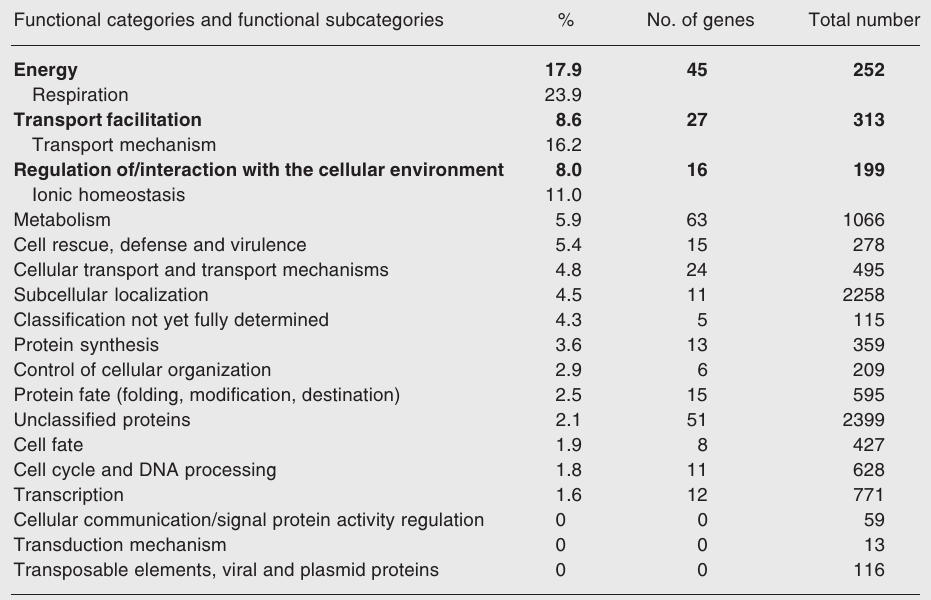
Table 1. List of functional categories and subcategories activated by nitrogen gas pressure. Functional categories and functional